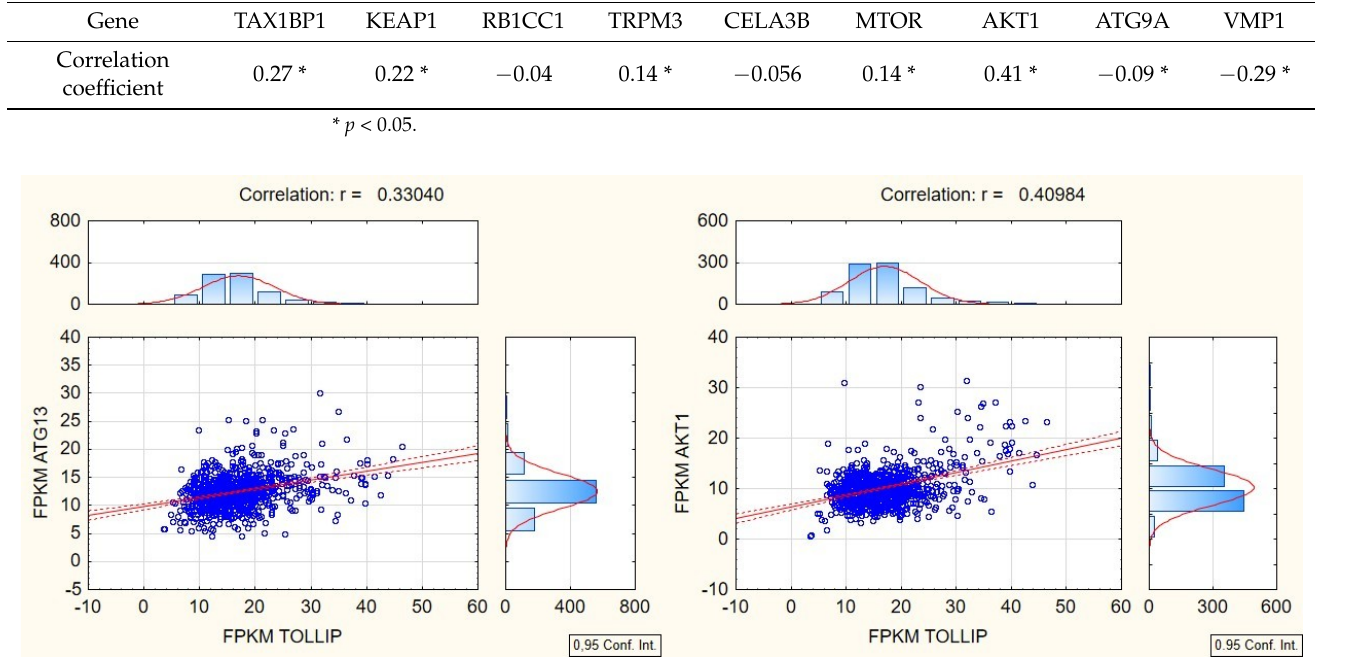
Figure 7. The correlation between the expression of TOLLIP and ATG13 ( left ) and between TOLLIP and AKT1 ( right ) in the TCGA cohort.